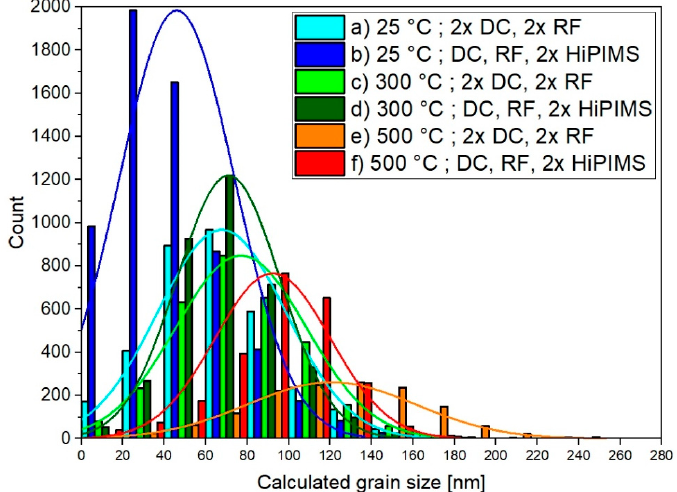
Figure 3. Calculated equivalent grain size distribution for each processing condition based on replacing the area of each grain at the surface extracted by image processing with an equivalent circular area. The lines are normal distributions fitted to each histogram as a guide for the eye. The DC, RF, 2 × HiPIMS conditions had a higher number of grains and smaller grains compared to the 2 × DC, 2 × RF conditions. However, for both cases, the grain size increased with increasing deposition temperature. The grain size distributions of the DC, RF, 2 × HiPIMS conditions were narrower than the grain size distributions of the corresponding 2 × DC, 2 × RF conditions.